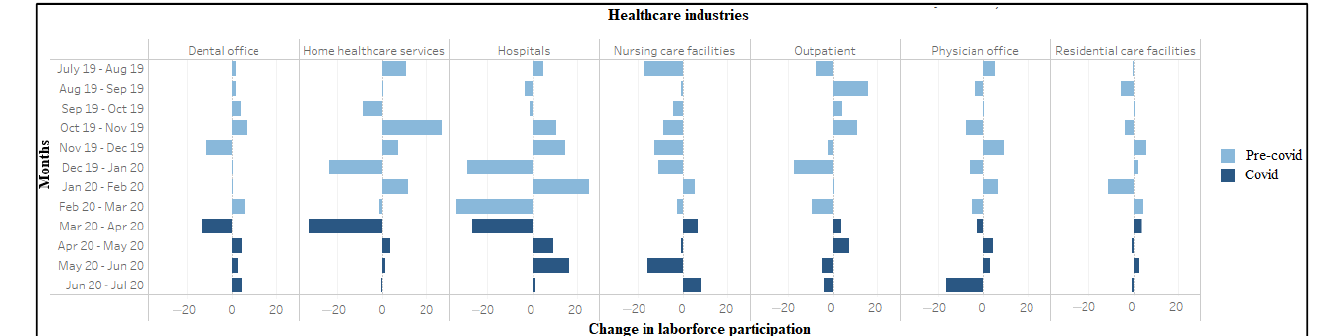
Figure 4. Change in employment (in ten thousand) among workers in healthcare occupations (July 2019–2020).